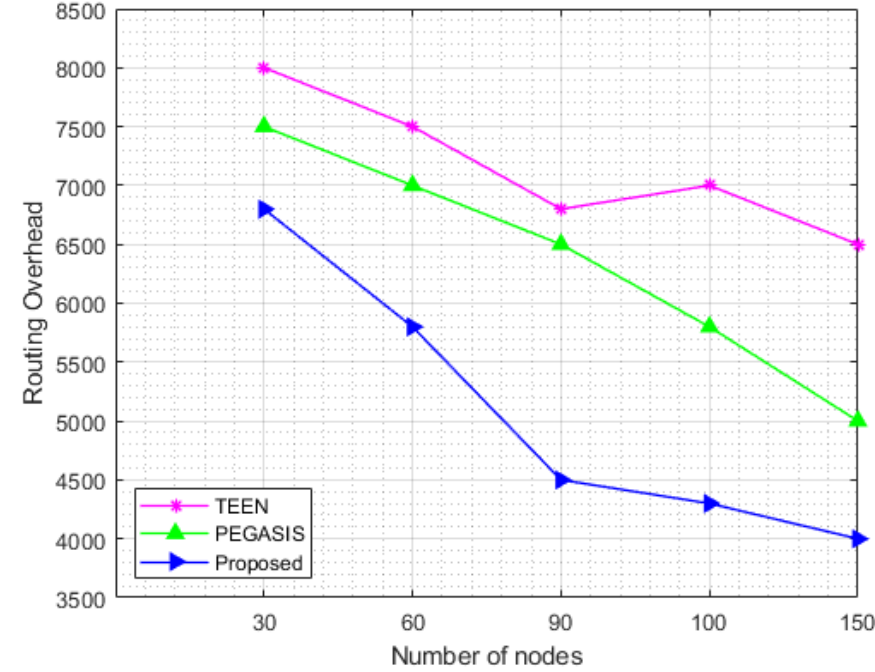
Figure 11. Number of nodes vs. Routing Overhead (150 nodes).